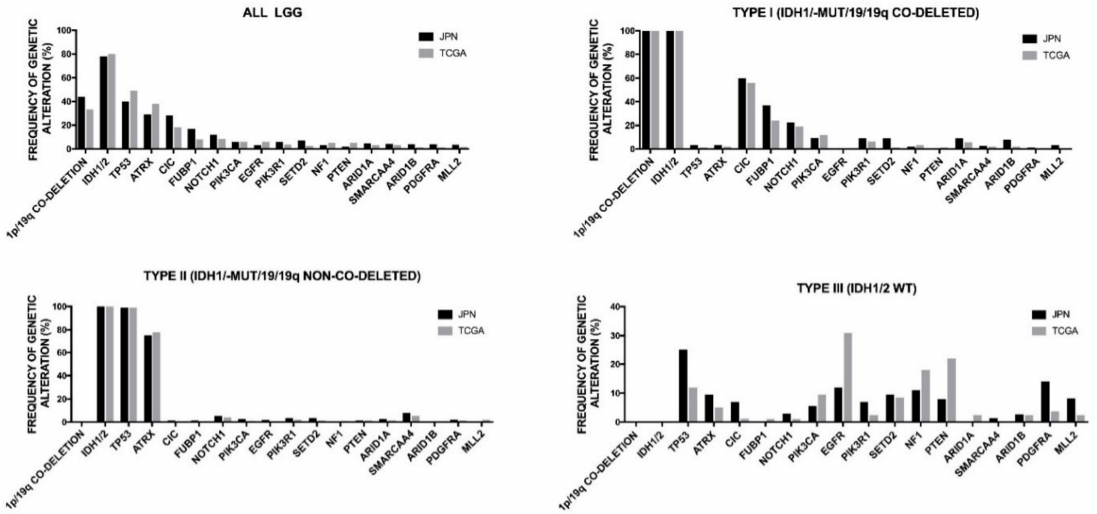
Figure 3. Genetic alterations observed in adult low-grade gliomas (LGG) subdivided into three groups (types) according to the absence or presence of IDH1/2 mutations and 1p and 19q deletions (panels B to D); in panel A, the genetic alterations observed in the whole population are reported. The data drawn in this figure are reported in the cancer genome atlas (TCGA) study on LGGs on Caucasian patients [101] and in the study of Suzuki et al. on Japanese (JPN) patients